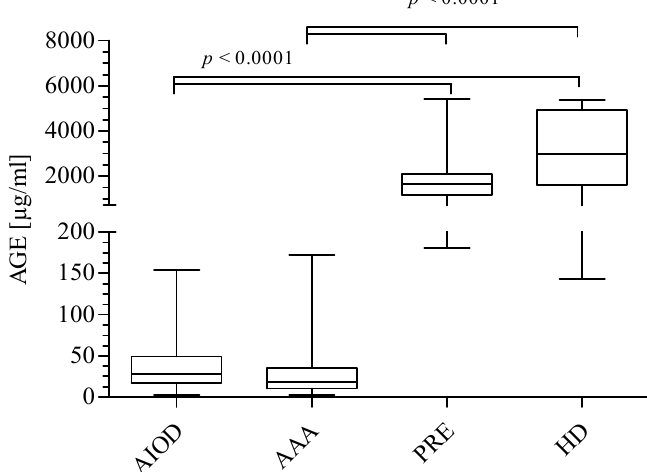
Figure 1. Concentrations of advanced glycation end products (AGEs) in the studied groups expressed as μ g/mL. The comparison of the four studied groups was performed using the Kruskal–Wallis test followed by Dunn’s multiple comparison test.